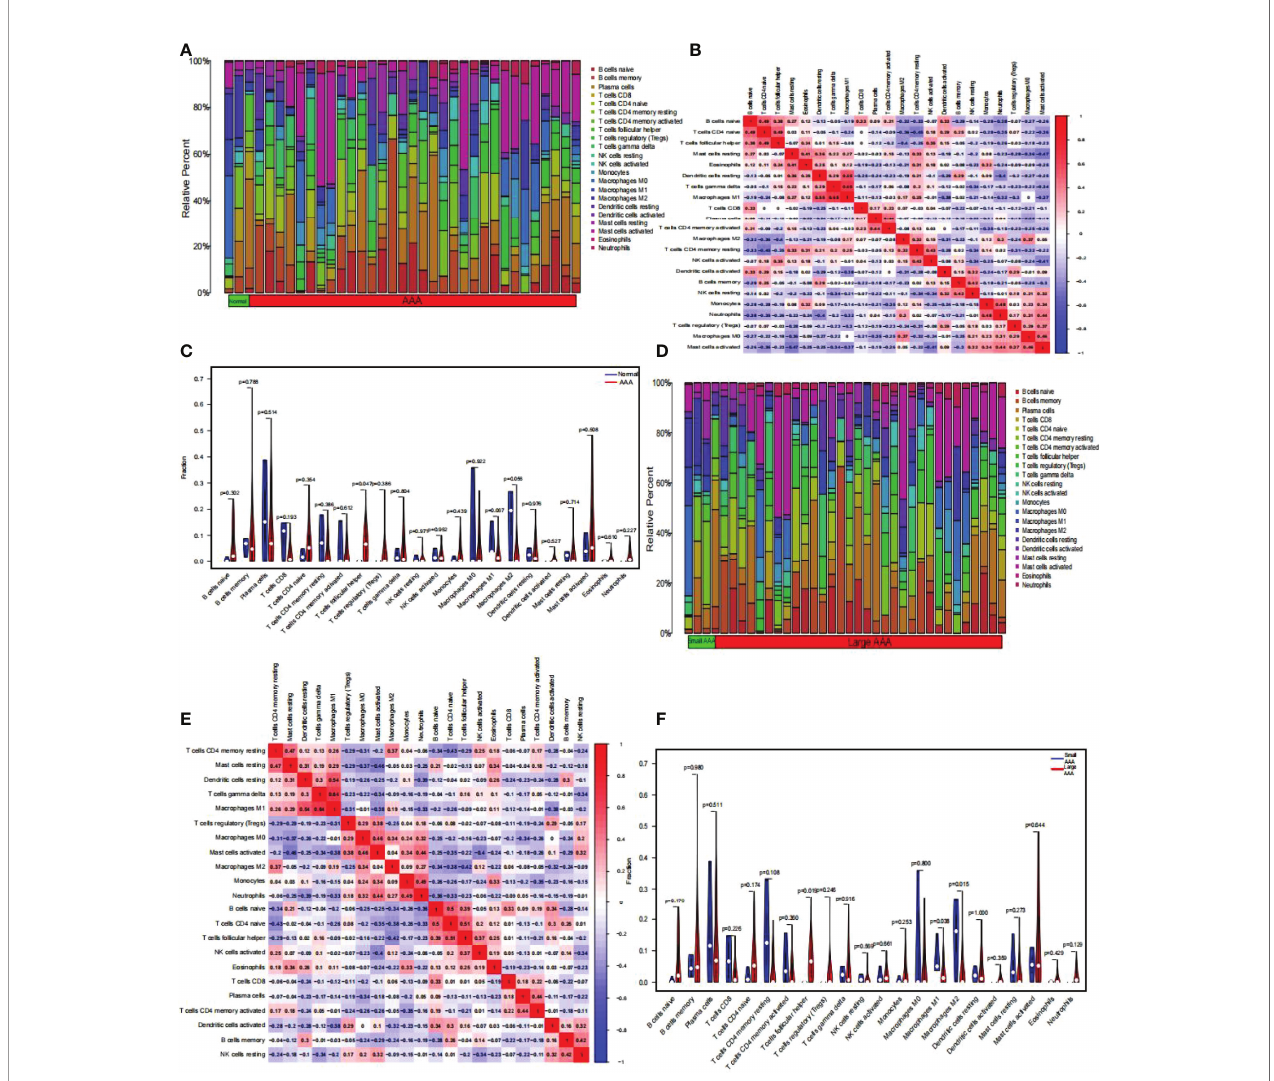
FIGURE 9 | Thecompositionofimmunecellswasanalyzedanddisplayed. (A) Heatmapofthe22 immunecellsubpopulationscomparingAAAandnormalsamples. (B) Heat mapshowingthecorrelationbetween22 different kindsofimmunecells inAAAandnormalsamples.Thesizeofthecoloredsquaresindicates theconnection ’ sstrength; red indicates apositivecorrelation,whileblueindicatesanegativecorrelation.Thestronger theconnection, theredderthehue. (C) Violindiagramillustratingtheproportionof22 differentkindsofimmunecells inAAAversusnormalsamples. (Normalsamplesweredenotedbybluecolor, whereas AAAsamples weredenotedbyredcolor.AAA, abdominal aorticaneurysm.P-values<0.05wereconsideredasstatisticallysigni fi cant). (D) Heatmapofthe22immune cellsubpopulationscomparinglargeAAAandsmallAAA samples. (E) CorrelationheatmapbetweenlargeAAA andsmallAAAsamples of22kindsofimmune cells.Thesizeofthe coloredsquaresindicatestheconnection ’ sstrength;red indicates apositivecorrelation,whileblueindicatesanegativecorrelation.Thestronger theconnection, theredderthehue. (F) Violindiagram illustratingtheproportionof22 differentkindsofimmunecells inlargeandsmallAAA samples.(ThesmallAAAsamples weremarkedwithbluecolor andlargeAAA sampleswere markedwith redcolor.AAA, abdominalaorticaneurysm. P-values< 0.05wereconsideredasstatisticallysigni fi